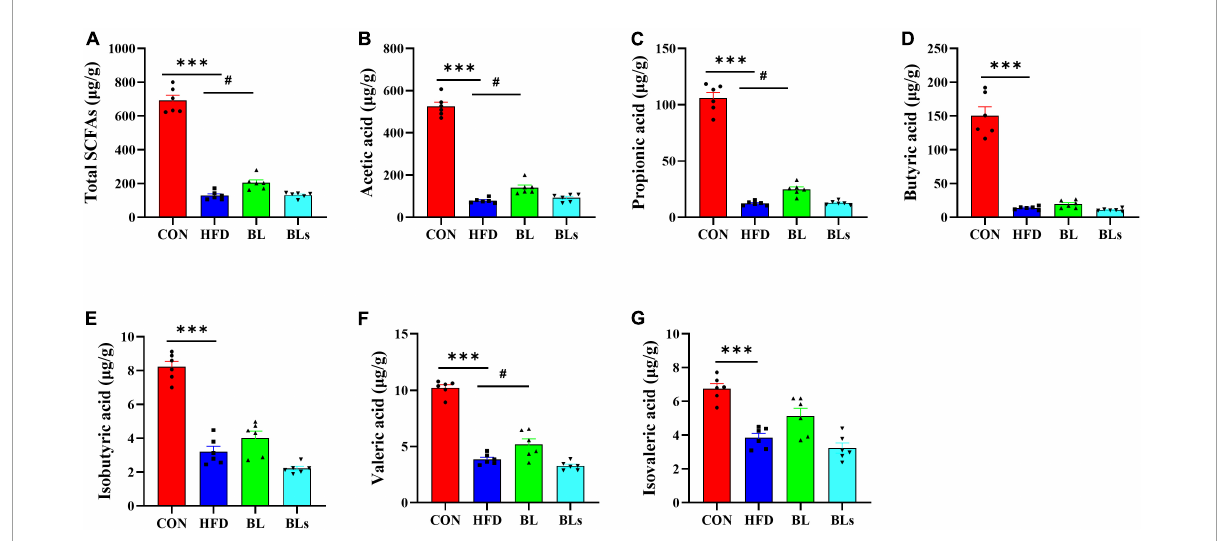
FIGURE8 Brevibacillus laterosporus BL1 treatment improved SCFA concentrations in HFD-fed mice. (A–G) Total SCFAs, acetic acid, propionic acid, butyric acid, isobutyric acid, valeric acid, and isovaleric acid. Data are presented as mean ± SEM ( n = 6) and analyzed using one-way ANOVA. Significant differences between HFD and CON are indicated by ∗∗∗ p < 0.001. Significant differences between HFD and BL are indicated by # p <